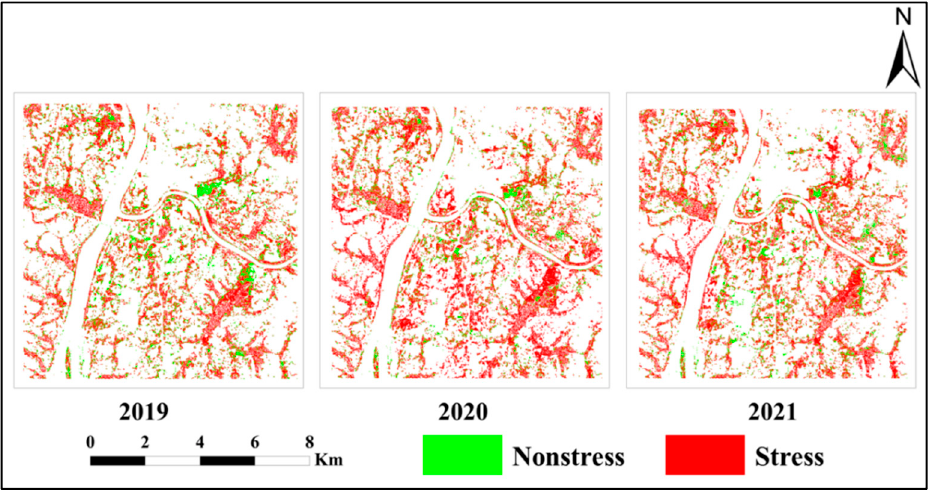
Figure 7. Spatial distribution of heavy metal-stressed rice from 2019 to 2021.